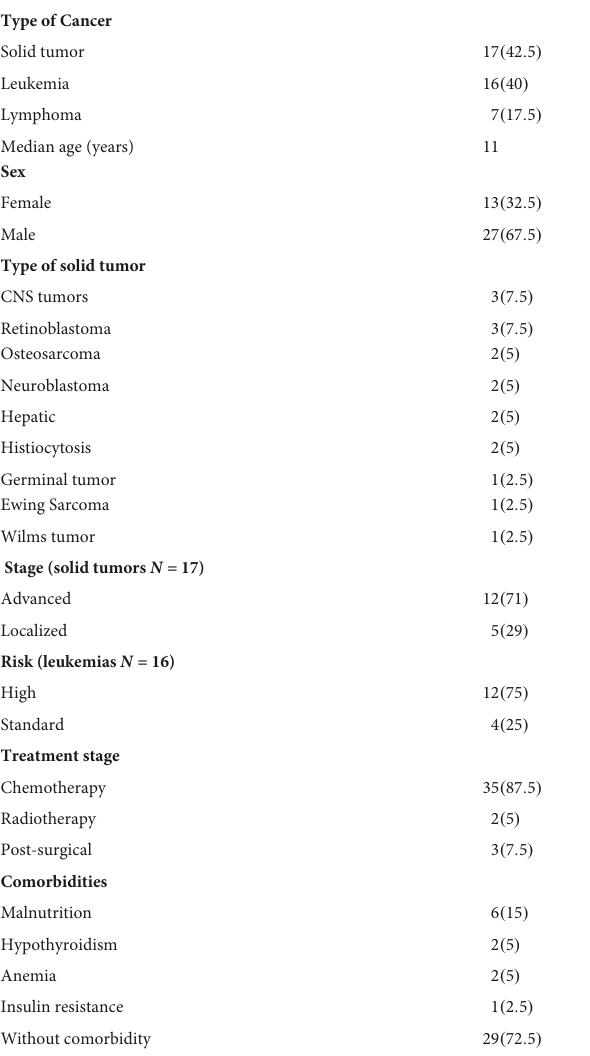
TABLE 1 General characteristics of the cohort.